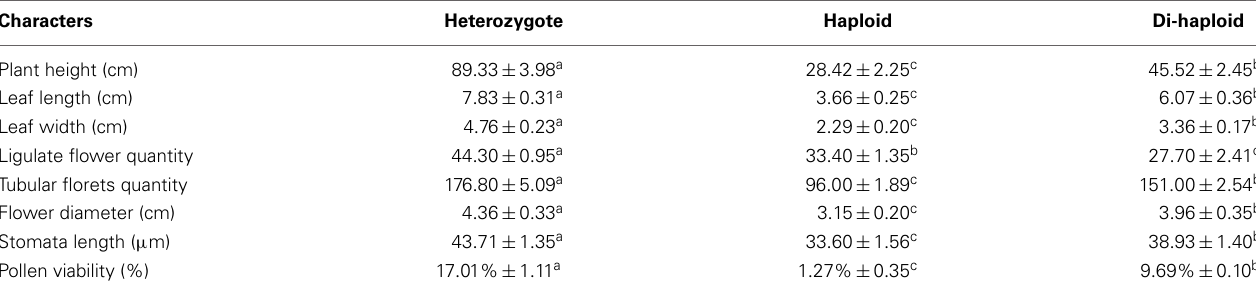
Table 3 | The morphology of “Zhongshanzigui” and its derived haploid and doubled haploid